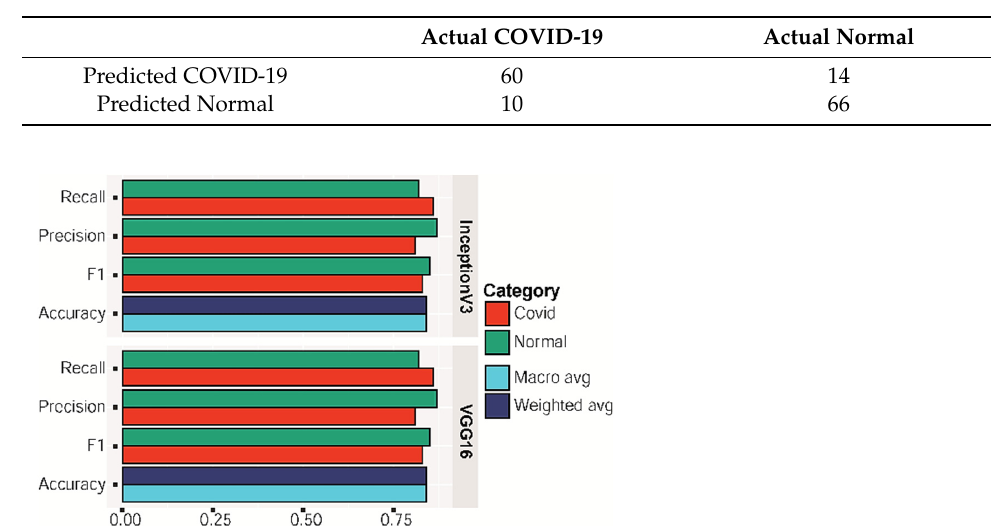
Table 7. Confusion matrix for performance of Inception-v3 on CT scans.